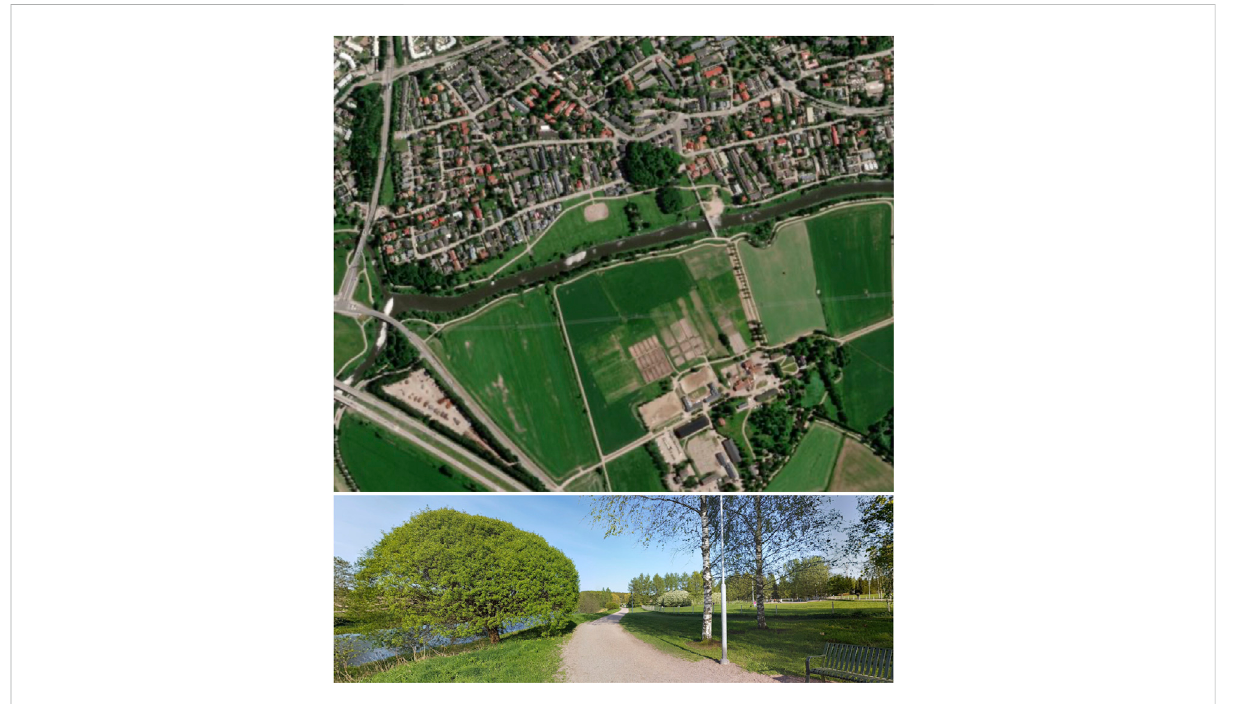
FIGURE 11 Physical wellbeing urban greenspace characteristics. Greenspace near Toyrynummi. Orthophoto Top — BingMaps (2022). Perspective bottom — GoogleEarth StreetView